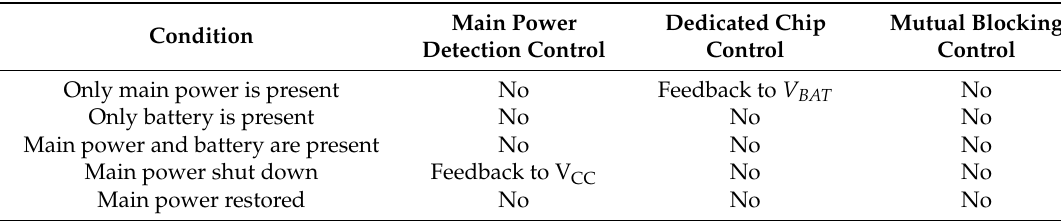
Table 3. Power voltage feedback